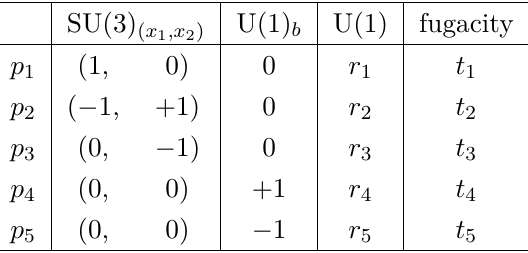
Table 12 . Global symmetry charges on the extremal brick matchings p i of Model